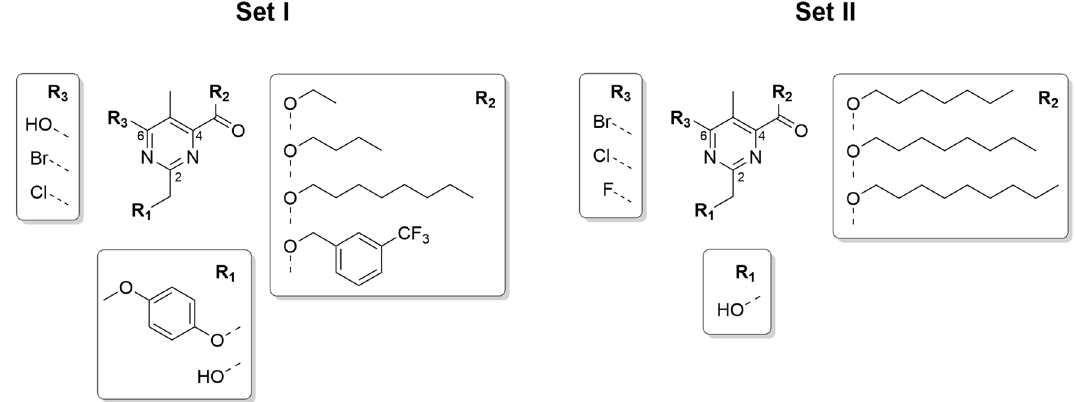
Figure 1. Sets I and II of the designed 2,4,5,6-tetrasubstituted pyrimidines with the scaffold and